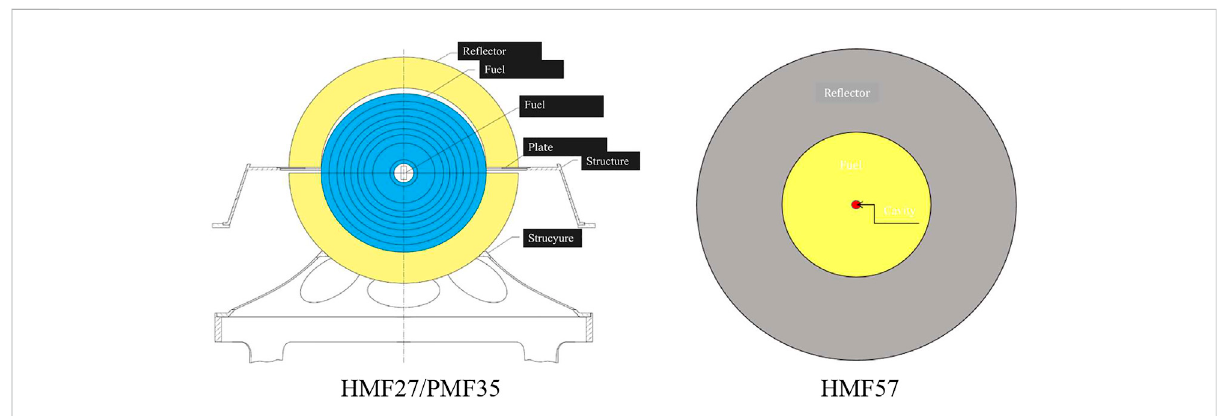
FIGURE 4 Diagrams of lead-based critical